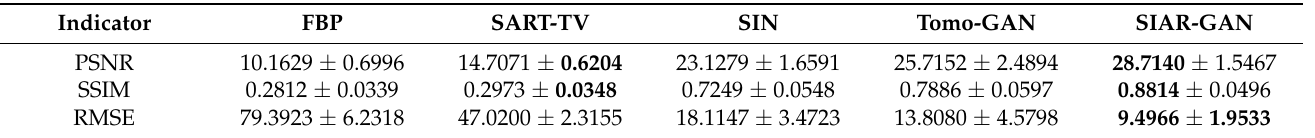
Figure 10. Reconstruction results of the head CT data from the 90 ◦ projection data. The first, third, and fifth rows of images are the reconstruction results of each method. The image in the first column in each of these rows is the reference image reconstructed by the standard FBP algorithm using the full scan. The subsequent columns show the images reconstructed by SIAR-GAN (2nd column), Tomo-GAN (3rd column), SIN (4th column), SART-TV (5th column), and FBP (6th column) algorithms. Below each reconstruction result, the residual image obtained by subtracting the corresponding reconstructed image from the reference image is shown. The pixel range of the residual images is [0, 255]. (Best viewed with zoom-in). Table 4. Average PNSR, SSIM, and RMSE results for the reconstruction results of the head CT data from the 90 projection data (mean standard deviation).